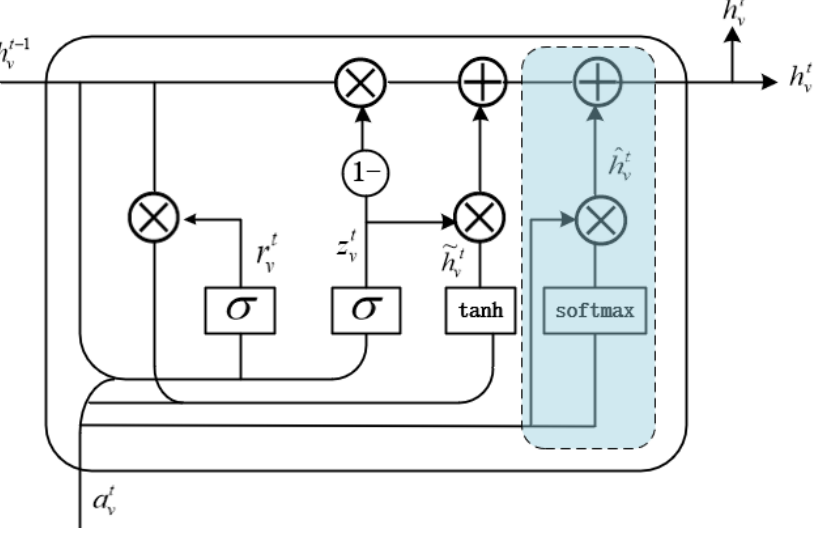
Figure 2. Gated Attention Unit GAU.